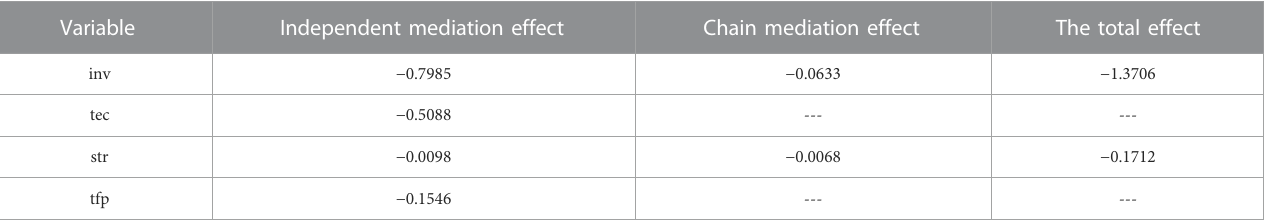
TABLE 7 Decomposition of the mediating effect.